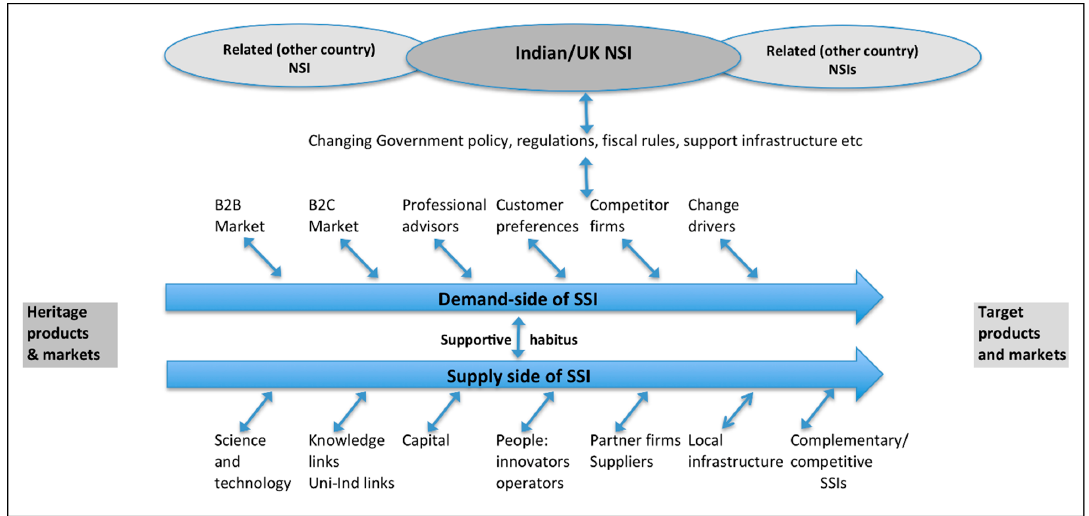
Figure 1. Conceptual representation of sectoral system of innovation (SSI) .